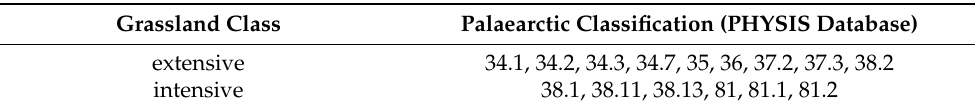
Table 1. Detailed habitat types and their subtypes were joined to represent general intensive and extensive grassland